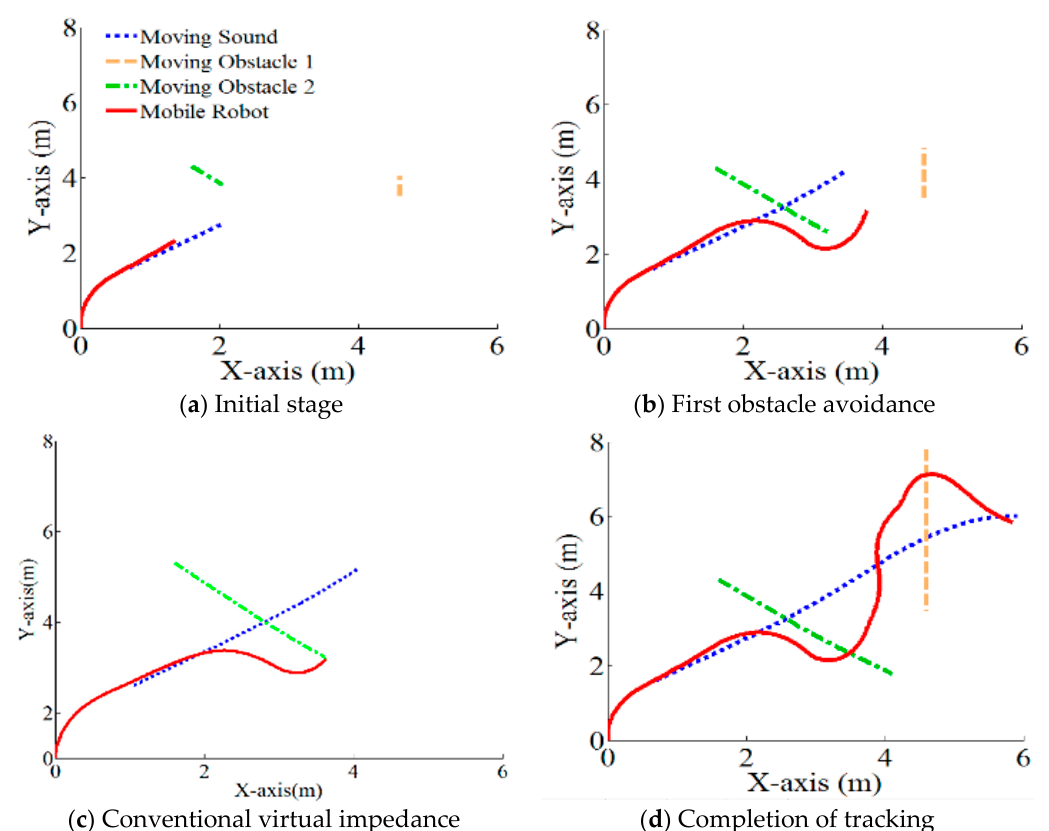
Figure 16. ( a ), ( b ), ( d ) The successful tracking of the sound source by the mobile robot using the active